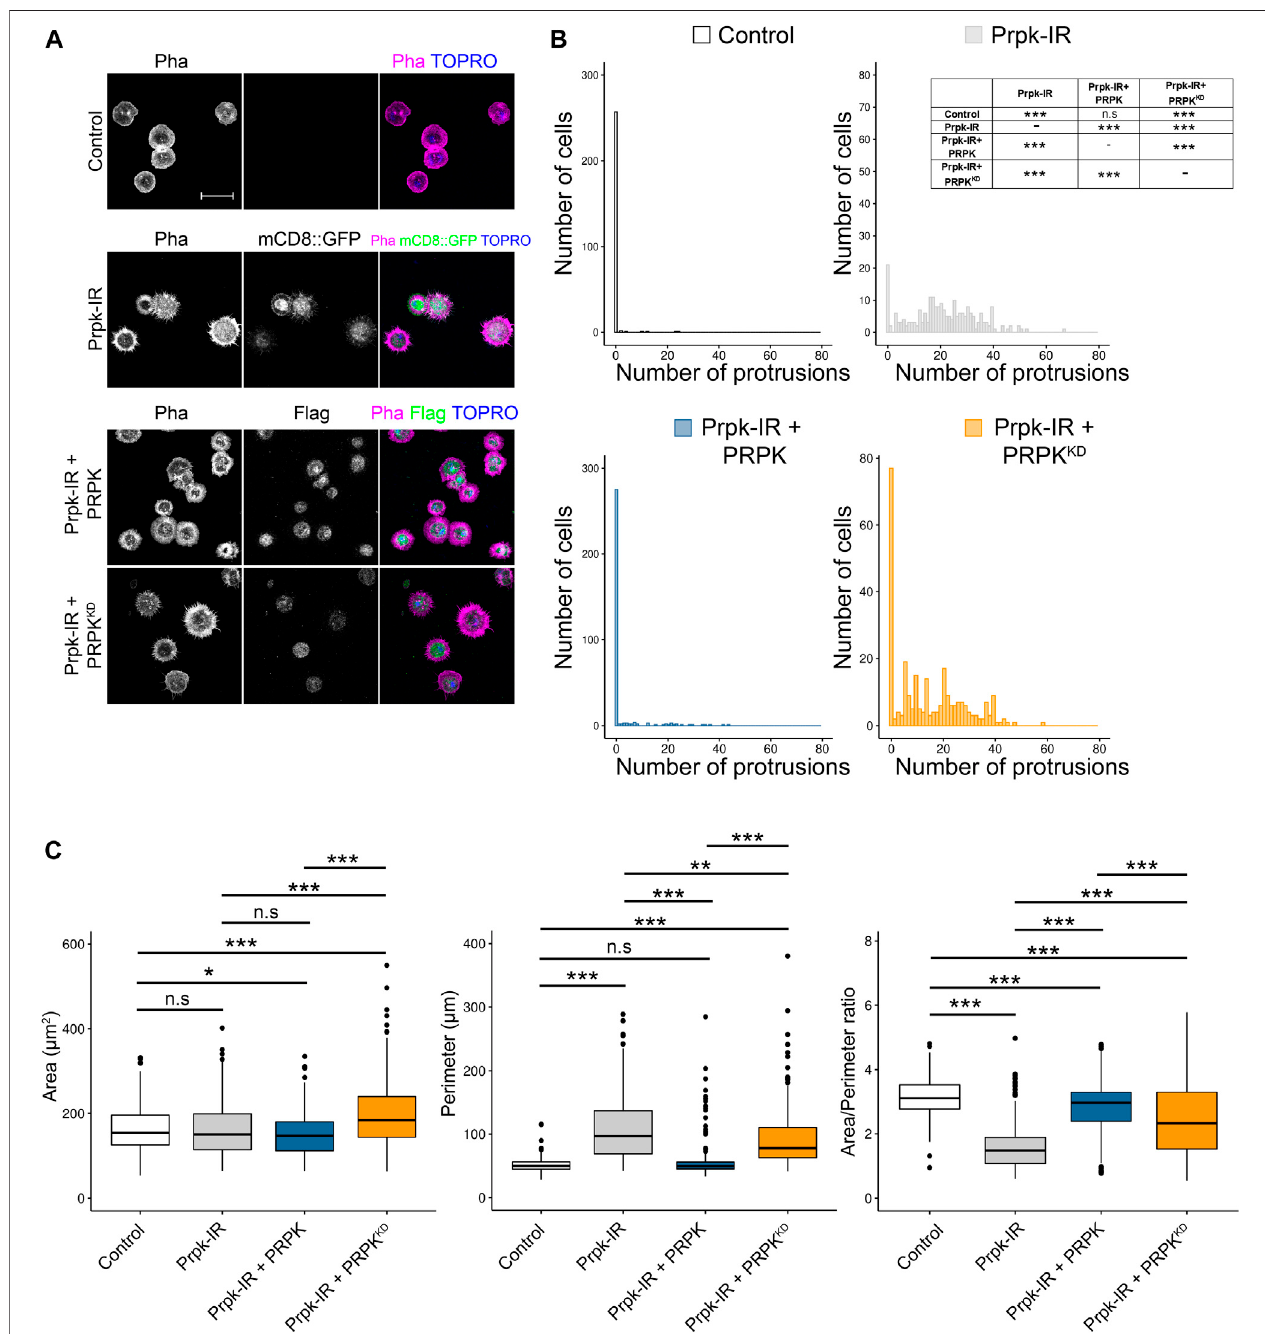
FIGURE6| Prpkknockdownphenotypecanberescuedbytheco-expressionofmurineorthologue(PRPK)butnotbythekinasedeadversionofPRPK(PRPK KD ). (A) ConfocalimagesofF-Actinstainedwithphalloidininprimarycultureofhemocytesexpressing:mCD8:GFP ( Control),PrpkRNAi(Prpk-IR),Prpk-IR+PRPKandPrpk- IR+PRPK KD usingCg-Gal4driverineachcondition.Scalebar:10 μ m. (B) Quanti fi cationofnumberofprotrusionsforeachconditiondetailedpreviously.Dataareshown as frequency of cellswithprotrusionsand the statistical differences aresummarized in the inserted table The Kolmogorov-Smirnovtest wasused for data analysis, with a Bonferroni correction: * p < 0.05, ** p < 0.01, *** p < 0.001; n ≥ 4 (number of coverslips analyzed, quanti fi ed over 150 cells in each case). (C) Cell morphology quanti fi cation expressed like Area, perimeter and Area/perimeter ratio for each condition. Kruskal – Wallis test was used for data analysis, followed with pairwise comparisons using Wilcoxon rank sum test, comparing all conditions to each other. * p < 0.05, ** p < 0.01, *** p < 0.001; n ≥ 4 (number of coverslips analyzed, quanti fi ed over 150 cells in each